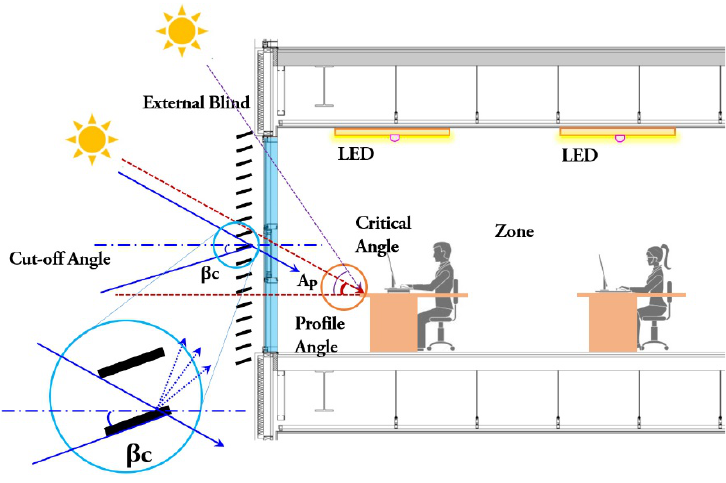
Figure 3. Concepts of the cut-off angle and profile angle.